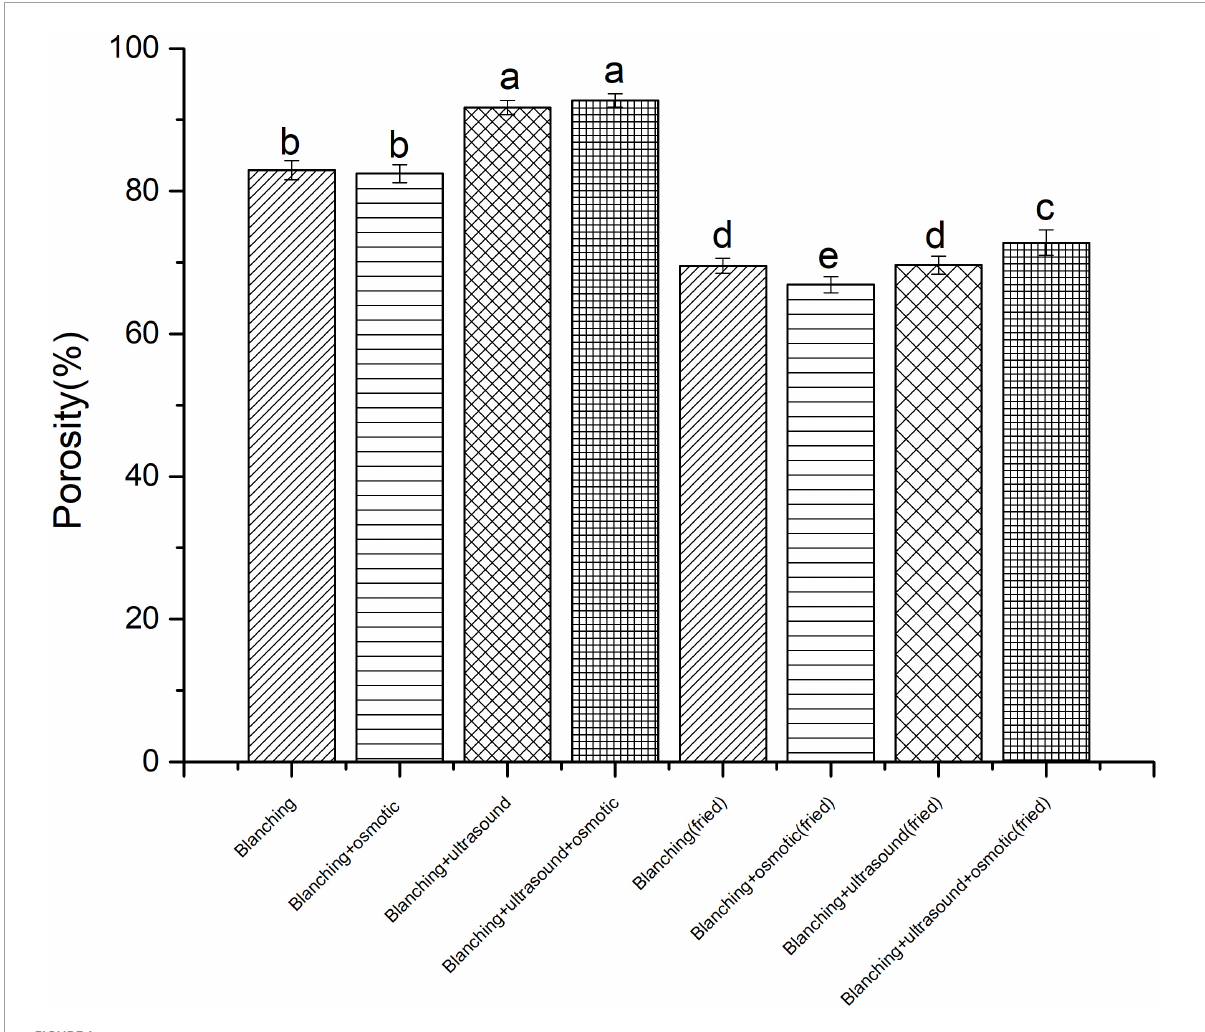
FIGURE1 Porosity of Pleurotus eryngii chips. Different superscript letters in the graph indicate significant differences between means ( P <